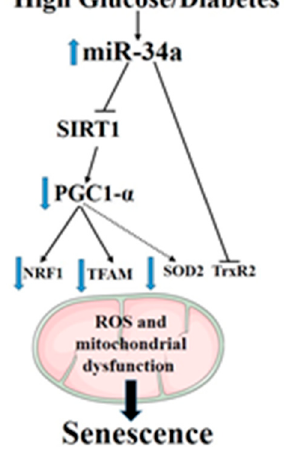
Figure 10. A summary diagram showing the role of miR-34a in regulating high-glucose-induced senescence in retinal endothelial cells.